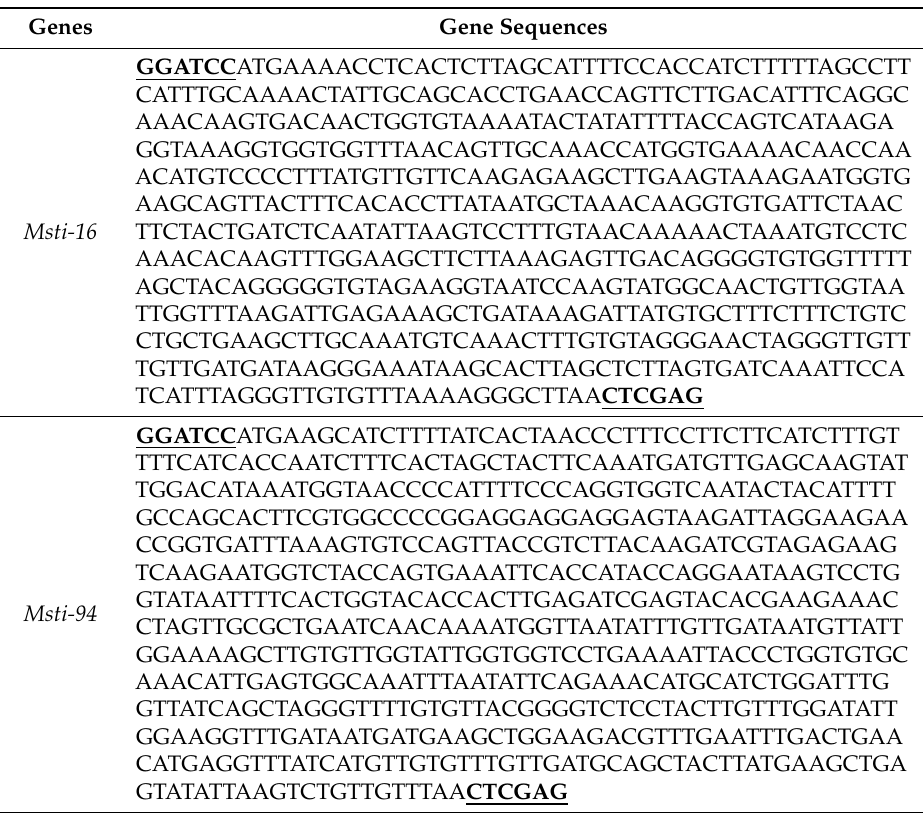
Table 3. Selected Msti-16 and Msti-94 genes for their gene sequences.